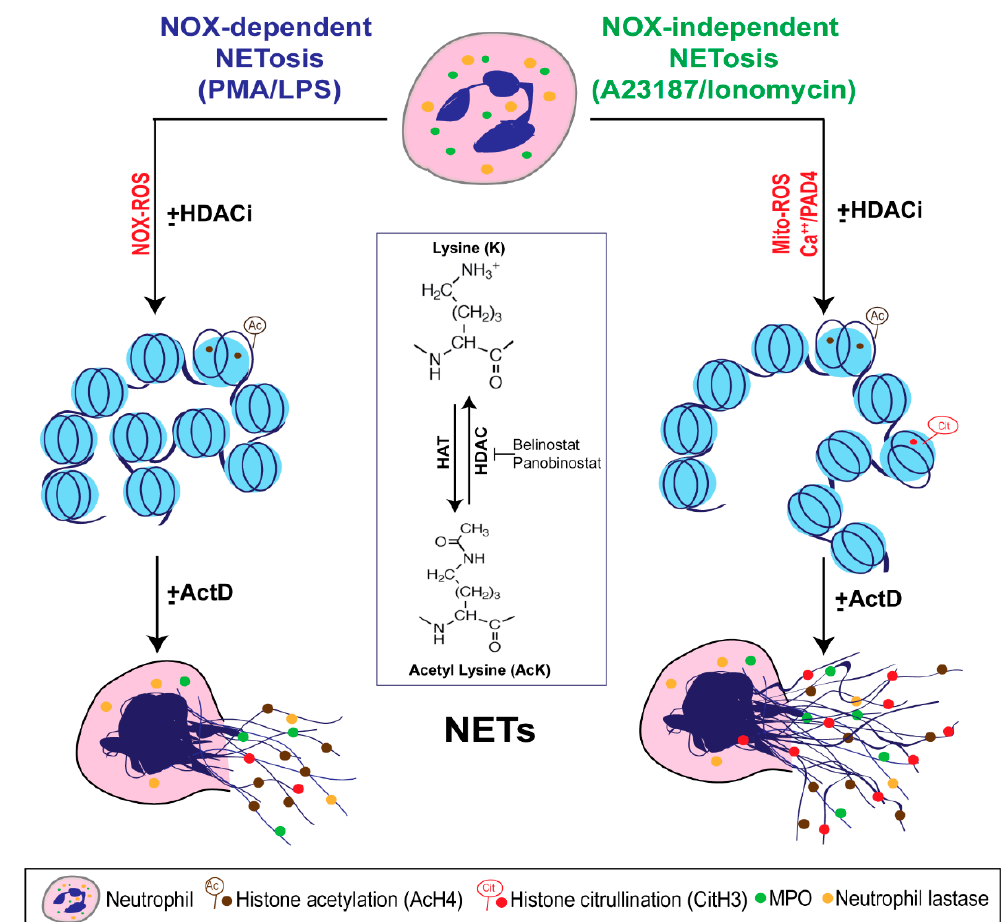
Figure 7. A unifying model showing the role of histone acetylation in NETosis. PMA and LPS induce nicotinamide adenine dinucleotide phosphate (NADPH) oxidase (NOX)-dependent whereas calcium ionophores such as A23187 and ionomycin activate NOX-independent pathways of NETosis. NOX-dependent and -independent pathways exert their downstream effects by inducing NOX ROS and mitochondrial ROS, respectively. After several intermediate steps, chromatin decondenses to become NETs. In the resting neutrophil nuclei, negatively charged DNA wraps around highly positively charged histones (e.g., amino acids arginine and lysine) to form tightly compacted chromatin. Addition of an acetyl group (H 3 C-C=O) to the tip of the side chain (-NH 3 ) of the N-terminal lysines of histones (e.g., H4 histone with K5 acetylation; H4K5ac, or AcH4) eliminates the positive charge (middle inset). Hence, histone acetylation weakens the overall chromatin structure, and particularly uncompacts the nucleosomes at promoter regions to allow the entry of various proteins to access DNA (e.g., transcription machinery). Histone acetyl transferases (HAT) add acetyl groups to lysine residues whereas histone deacetylases (HDACs; 18 in neutrophils) remove the acetyl groups. A balance between HAT and HDAC activities determines the degree of histone acetylation. HDAC inhibitors (HDACis; e.g., Belinostat, Panobinostat) shift the balance towards increased acetylation of histones. This modification promotes baseline as well as NOX-dependent and -independent NETosis. Since HDACis modify histones that are downstream of ROS production, they do not affect ROS production during NETosis. During the induction of calcium ionophore-mediated NOX-independent pathway, increase in intracellular calcium concentrations also enables the cytoplasmic peptidylarginine deiminase 4 (PAD4) to translocate into the nuclei. This active form of PAD4 (PAD4:Ca 2+ complex) citrullinates the histones (i.e., the removal of the positive charge from arginine; e.g., CitH3) particularly at the promoter regions. This modification also facilitates transcription. Process of genome-wide transcription is necessary for decondensation of chromatin for both types of NETosis. In summary, acetylation of histones promotes transcription and subsequent chromatin decondensation during baseline NETosis as well as both NOX-dependent and NOX-independent NETosis.